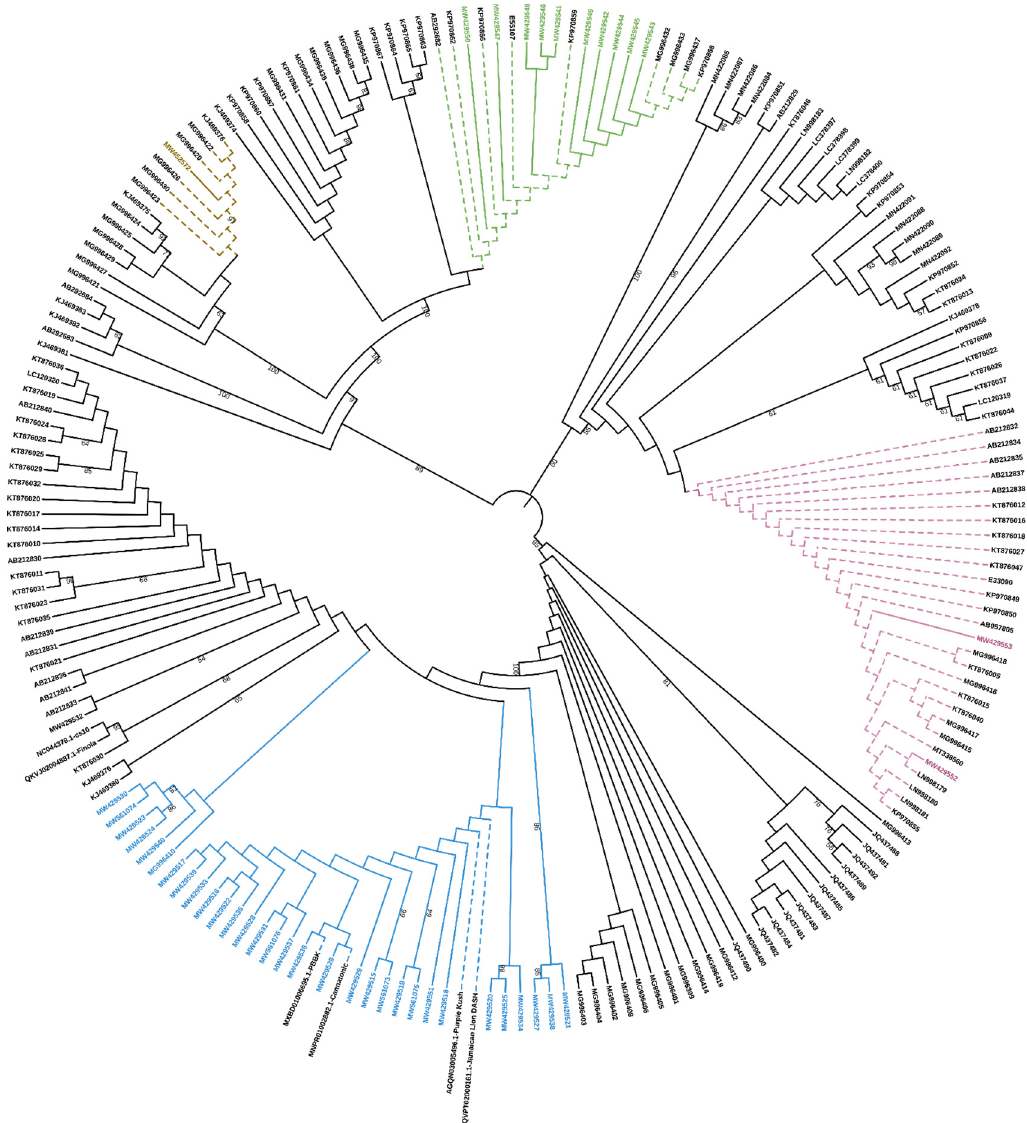
Figure 1. Phylogenetic tree analysis of 202 cannabinoid synthase genes from C. sativa at nucleotide level. The tree colors reflect the scheme presented by Van Velzen and Schranz in their Supplementary Figure S1. New CBCAS sequenced in the present work are in blue (clade A2), in pink new THCAS (clade A1) and in green new CBDAS sequences (clade, B, brown for clade B2-CBDAS). The optimal tree with the sum of branch length = 0.49420587 is shown. Branches corresponding to partitions reproduced in less than 50% bootstrap replicates are collapsed. The percentage of replicate trees in which the associated taxa clustered together in the bootstrap test (1000 replicates) are shown next to the branches [28]. The evolutionary distances were computed using the Maximum Composite Likelihood method [29] and are in the units of the number of base substitutions per site. Codon positions included were 1st + 2nd + 3rd + Noncoding. All ambiguous positions were removed for each sequence pair (pairwise deletion option). There were a total of 1906 positions in the final dataset.